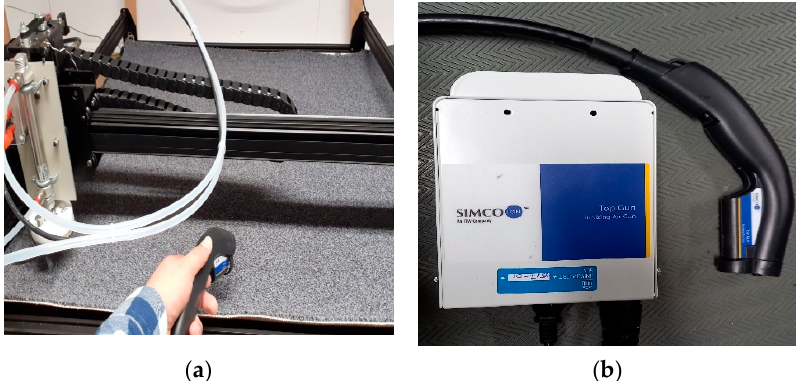
Figure 5. Setup with air gun to remove the residual charges on the carpet; ( a ) Use of air gun on the floorcovering to remove the residual charge ( b ) air gun.